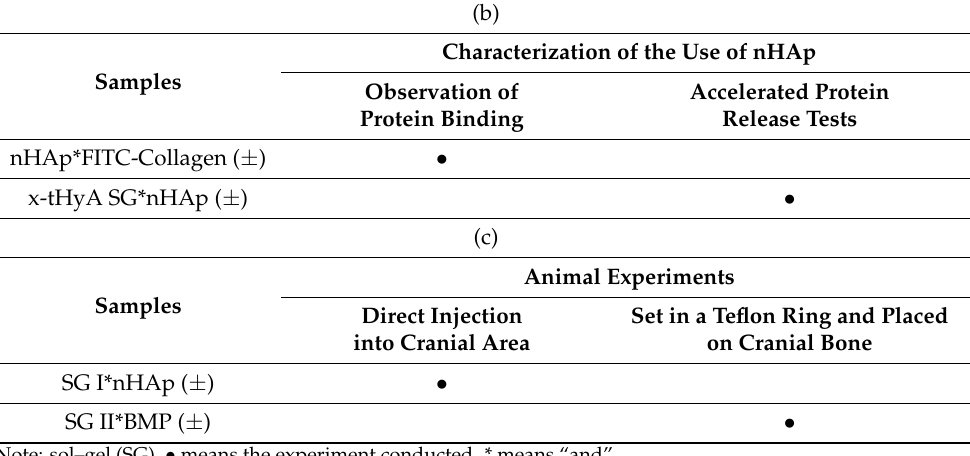
(b) Characterization of the Use of nHAp Observation of Protein Binding